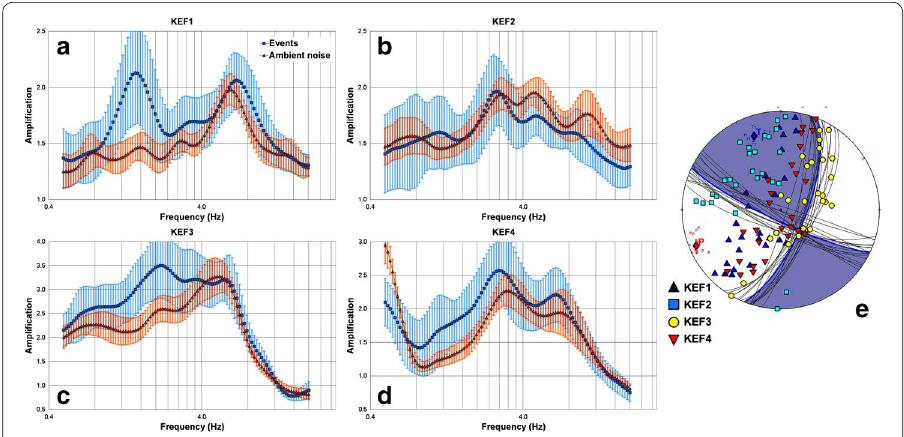
Fig. 10 Comparison between HVSR curves using ambient noise and small earthquakes recorded at stations KEF1 ( a ), KEF2 ( b ), KEF3 ( c ), and KEF4 ( d ). Error bars denote standard deviation of the average ambient noise and earthquakes HVSR value. The beach-ball ( e ) displays the individual ( thin lines ) and average ( bold lines ) nodal planes of the largest events’ (Mw 4.0) focal mechanisms (http://www.geophysics.geol.uoa.gr) and the ≥ corresponding lower-hemisphere projection of KEF1-4 seismographic